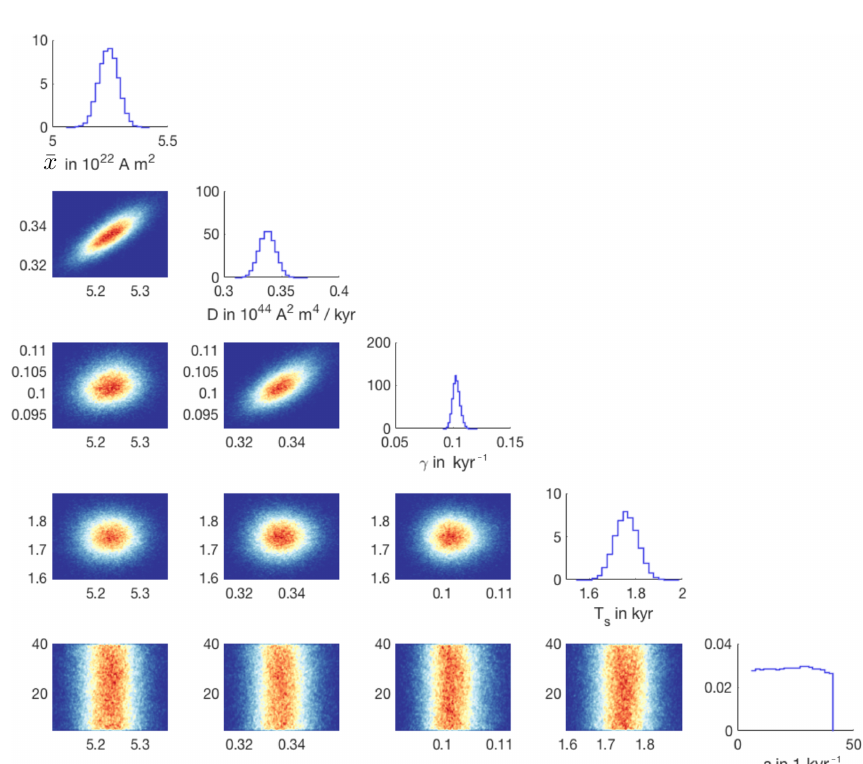
Figure 8. One- and two-dimensional histograms of the posterior distribution of configuration